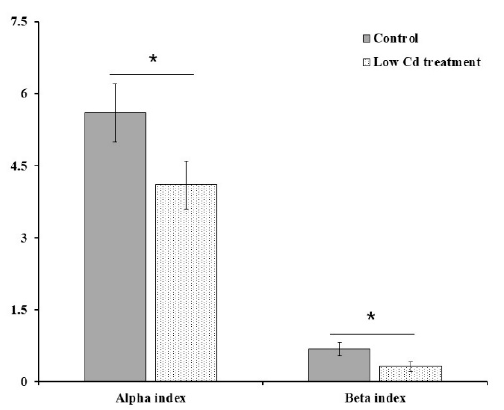
Figure 1. Alpha diversity and intragroup beta diversity of the control and low Cd treatment groups; * p < 0.05.